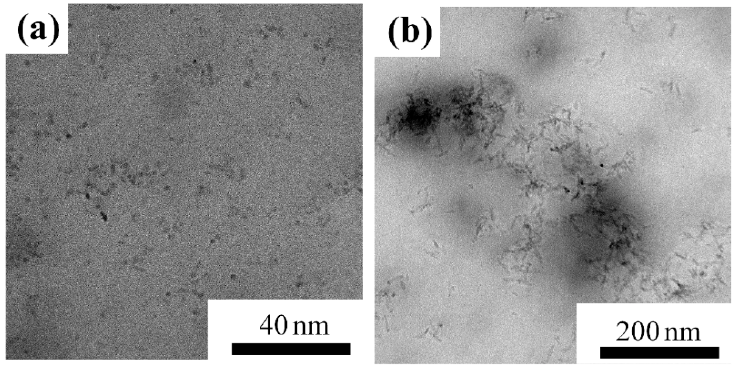
Figure 4. Transmission electron microscope (TEM) images for ( a ) TiO 2 nanospheres and ( b ) nanorods in nanofluids.